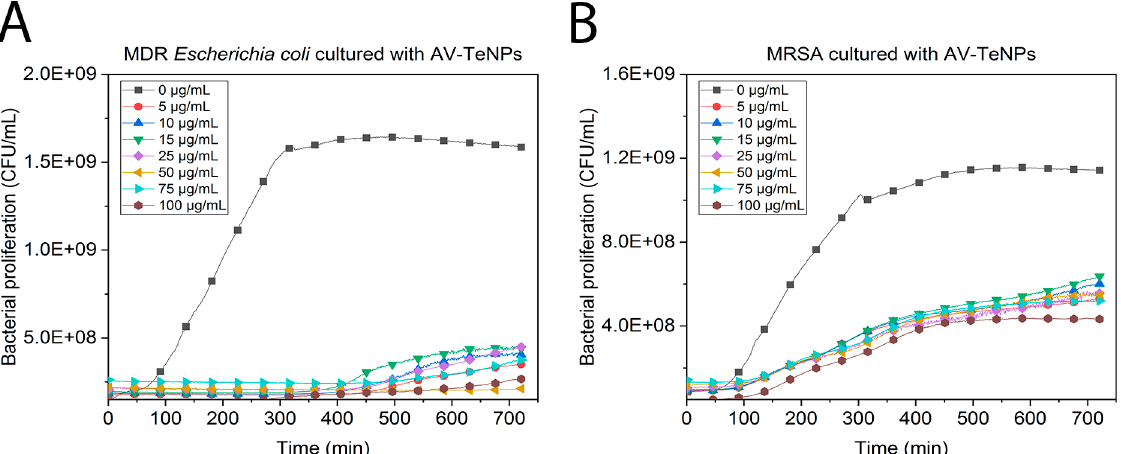
Figure A8. Effect of AV-TeNPs on the growth of a 1 × 10 6 CFU/mL suspension of multidrug-resistant (MDR) E. coli ( A ) and methicillin-resistant Staphylococcus aureus (MRSA) ( B ) for 24 h in the presence of different concentrations of AV-TeNPs. The values represent the mean ± standard deviation.